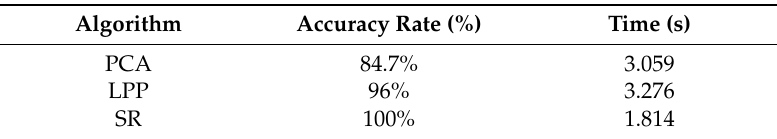
Figure 5. Projected data point distribution with vectors [y1, y2], ( a ) PCA, ( b ) LPP, ( c ) spectral regression (SR). Table 2. Accuracy rate and computation time of classification by K-means for original features, PCA, LPP and SR.